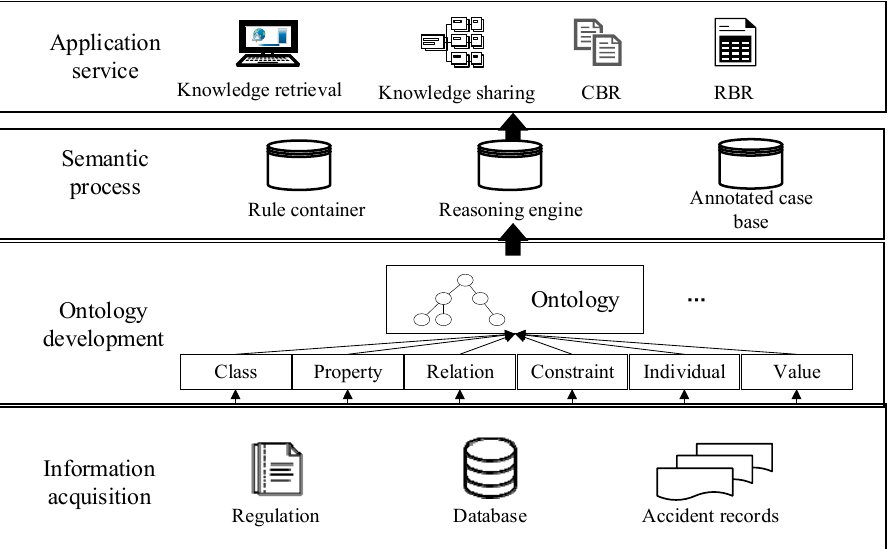
Figure 1. Overall architecture of the ontological case-based reasoning (CBR) system (adapted from Tao, et al. [41]). RBR: Rule-based reasoning.